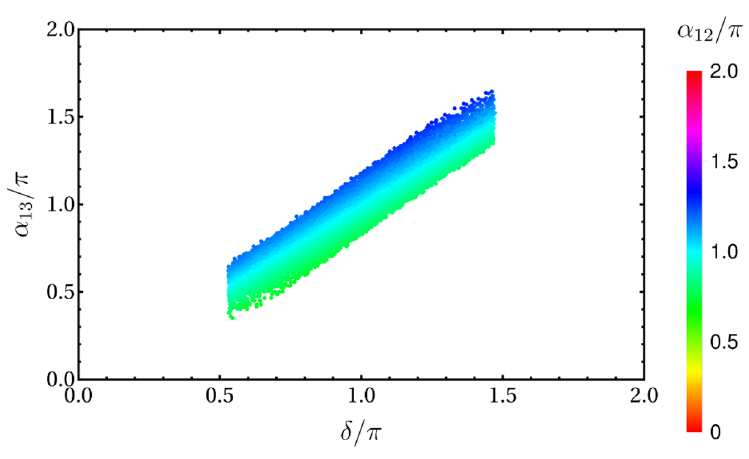
Figure 14 . Allowed parameter space for (cid:11) 12 , (cid:11) 13 and (cid:14) . Neutrino oscillation data was scanned over the 3 (cid:27) uncertainties, except (cid:14) which was left free. For points outside this region, either Y 11 is non-perturbative or Br( (cid:22) e(cid:13) ) is above the experimental !